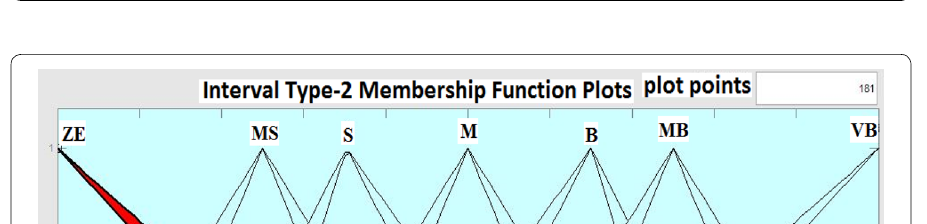
Fig. 18 Membership function for K P , K I and K D